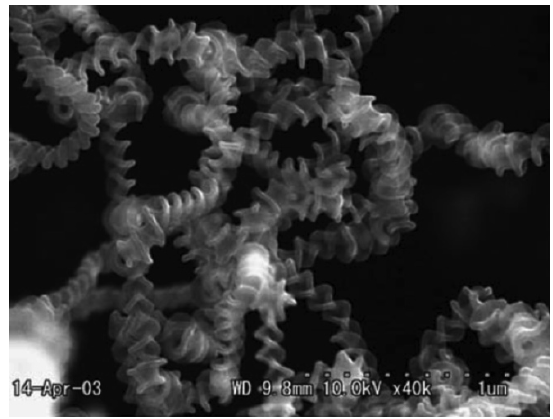
Figure 7. Representative twisted ribbon-like nanofibers grown by Fe 14 Cr 18 Ni 8 catalyst [35]. Reprinted with permission from [35], Copyright 2005